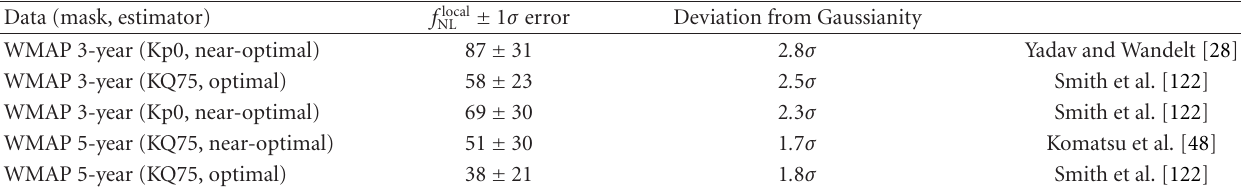
Table 1: Hint of local non-Gaussianity at 2 σ level.